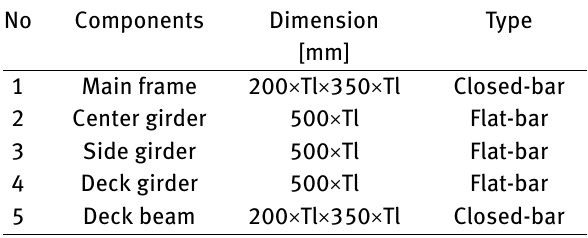
Table 5: Structural Members of the Ship Framing System Model